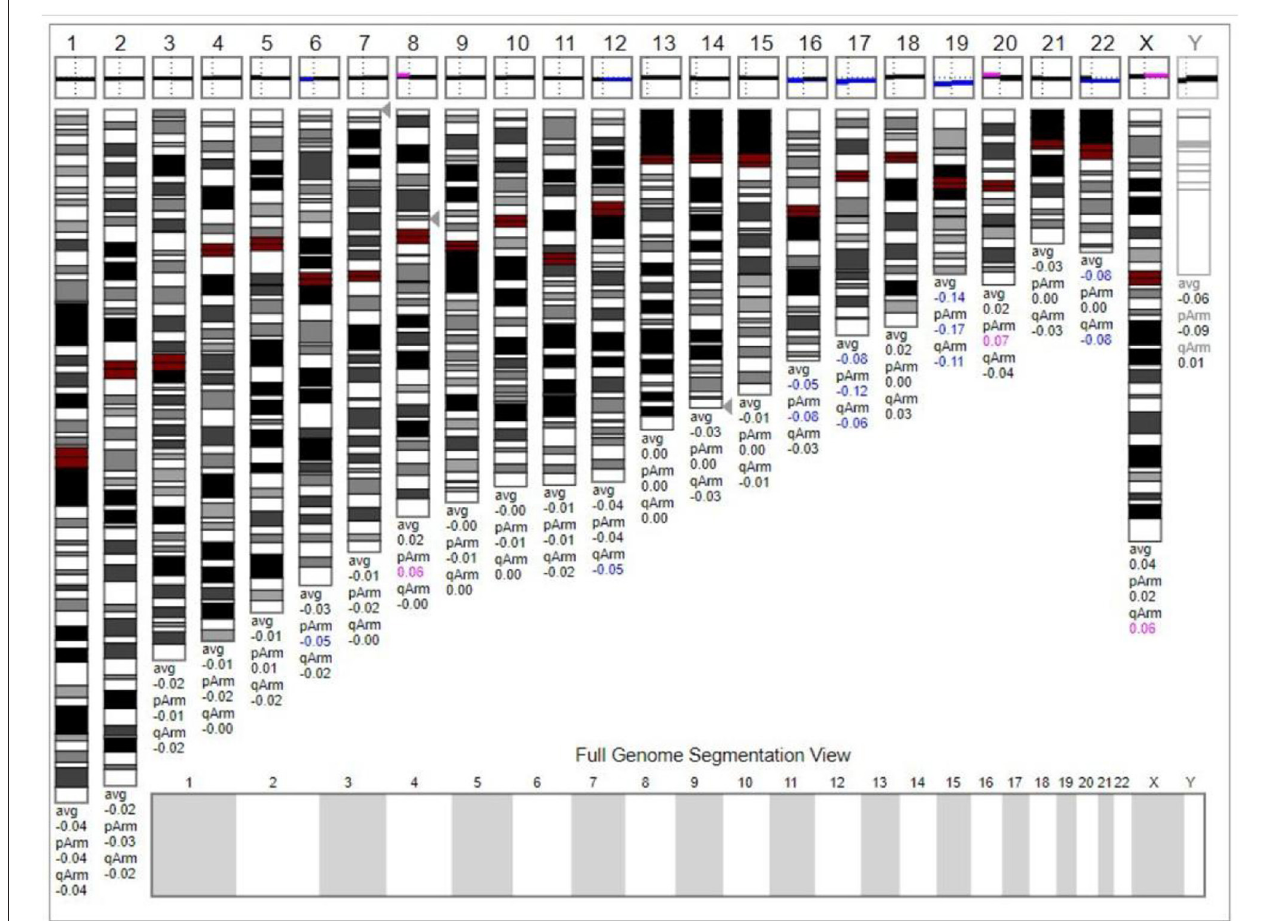
FIGURE 3 | The chromosome microarray did not detect duplicates or microdeletions in the chromosome. This karyogram was generated by Genoglyphix v3.0 according to the microarray results. Triangle markers on the right side of the chromosomes indicate the alteration locus. Pink indicates duplication; blue indicates deletion, and gray indicates duplication or deletion excluded by Genoglyphix